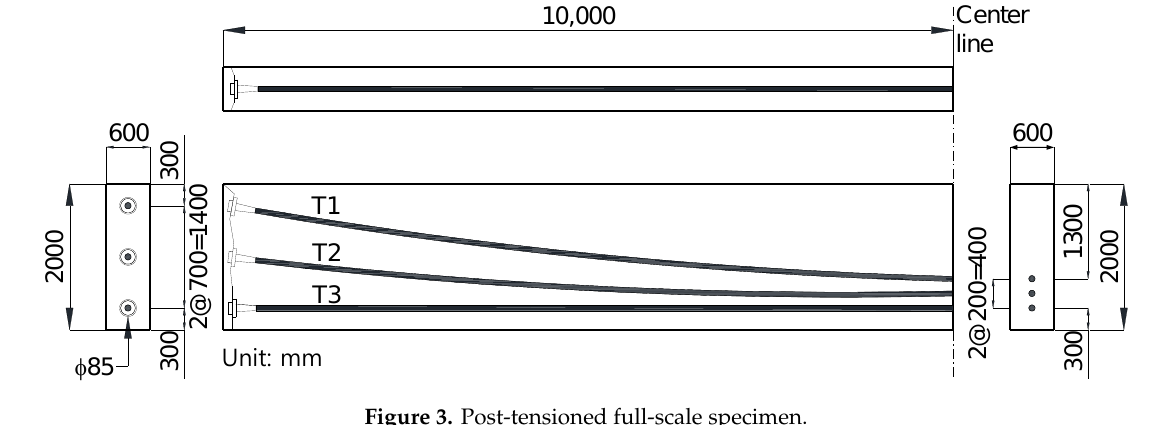
Figure 3. Post-tensioned full-scale specimen.